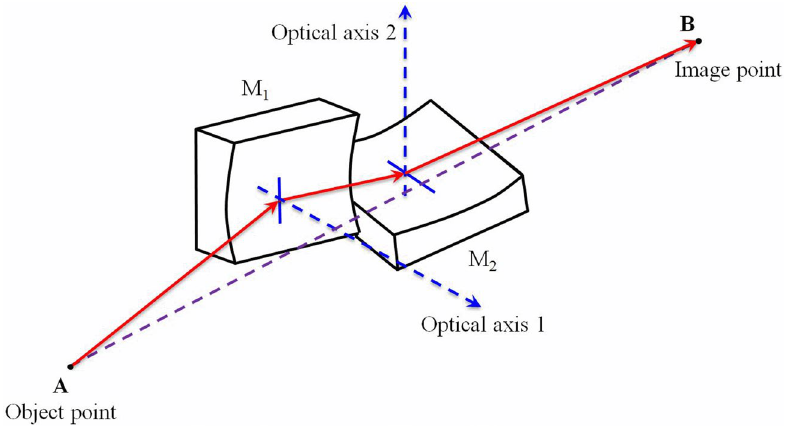
Figure 1. (Color online) Schematic illustration of KB